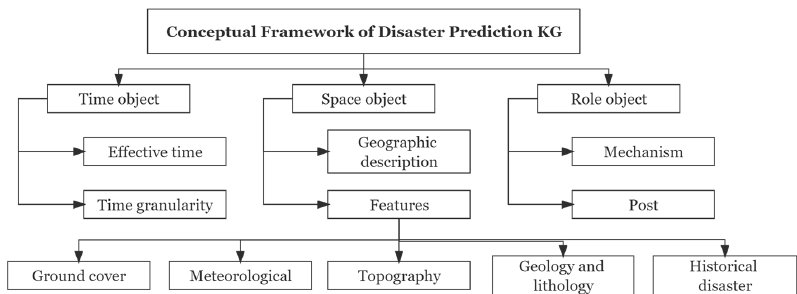
Figure 3. Common semantic ontology of disaster prediction.